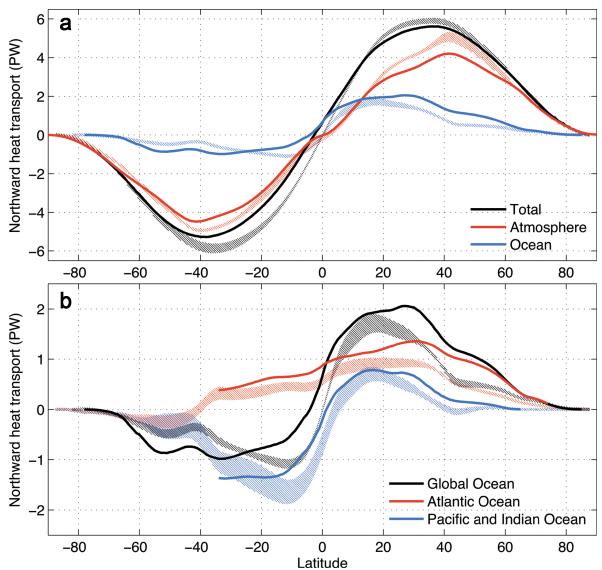
Fig. 15. (a) Northward heat transports for atmosphere (red line), ocean (blue line) and total (black line) from NorESM Historical1 years 1976–2005. The ocean heat transport are diag- nosed directly in the ocean component while the atmospheric transport is found by meridional integration of the difference between zonal integration of net TOA and surface heat fluxes. (b) Corresponding northward heat transports for the global ocean (black line), Atlantic Ocean (red line), and Pacific and Indian Ocean (blue line). The hatched areas in both panels are heat transports with uncertainty estimates from Fasullo and Trenberth (2008) where the CERES dataset is used for TOA terms.